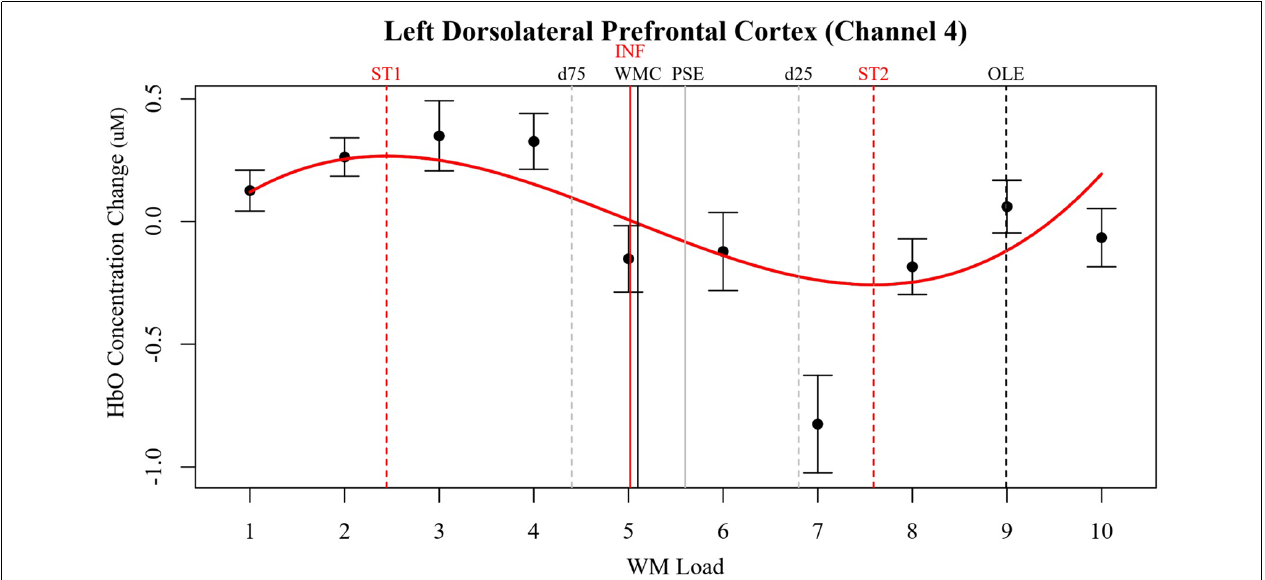
FIGURE 3 | Relative concentration changes in oxygenated hemoglobin (HbO) as a function of working memory load in the LDLPFC (Channel 4). Annotated from the behavioral models are the estimates of working memory capacity (WMC and PSE) as well as bounding estimates of optimal workload ( d 75 to d 25 ). HbO estimates of WMC (INF) and bounding estimates of optimal load are also annotated (ST1,